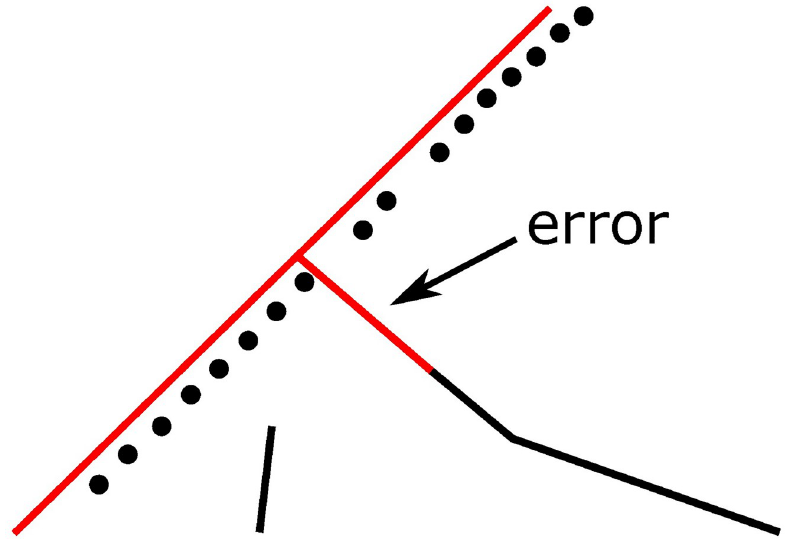
Fig 5. Part of the test chart of a normal junction.